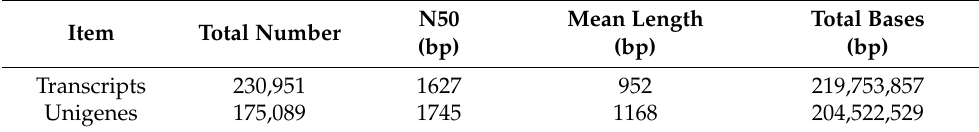
Table 2. Statistics of the de novo transcriptome assembly for D. loddigesii .